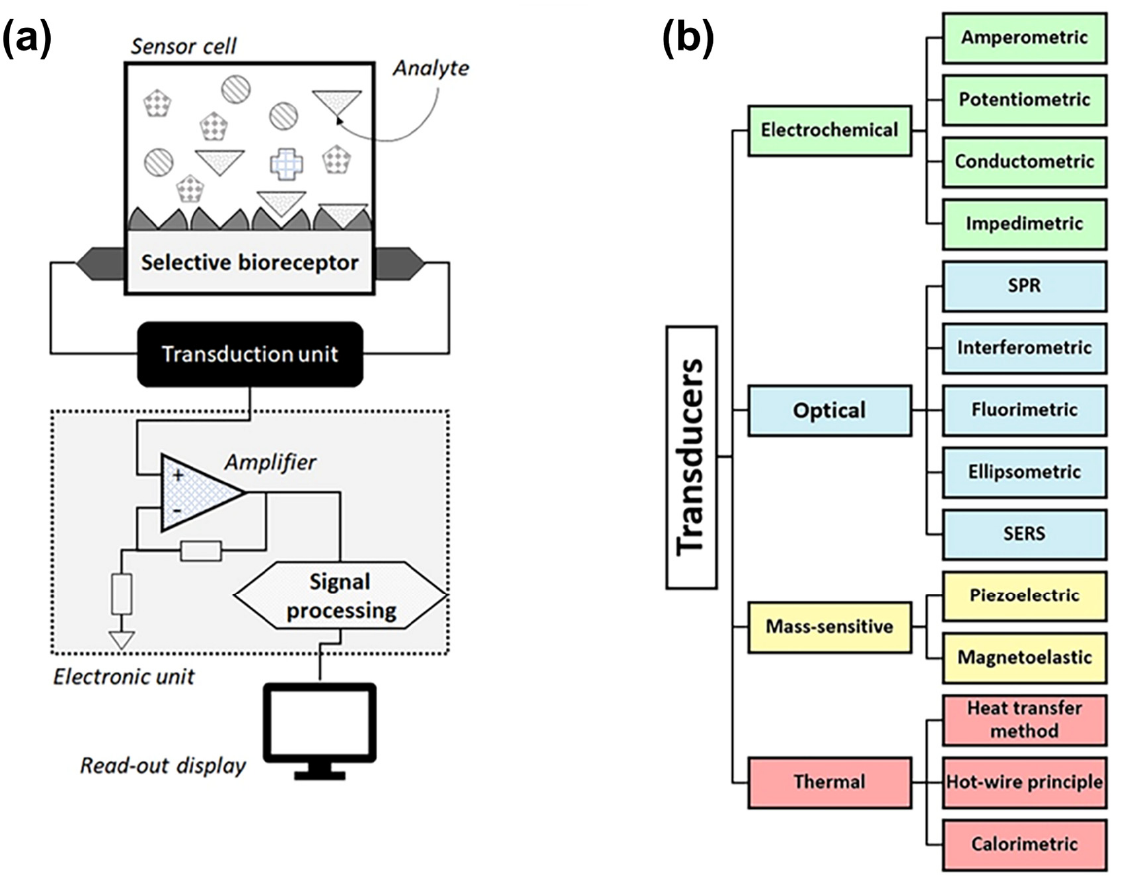
Figure 4. ( a ) Schematic representation of the key elements of a generic biosensor in which the analyte (target molecules) binds selectively to receptors, serving as biorecognition elements. The